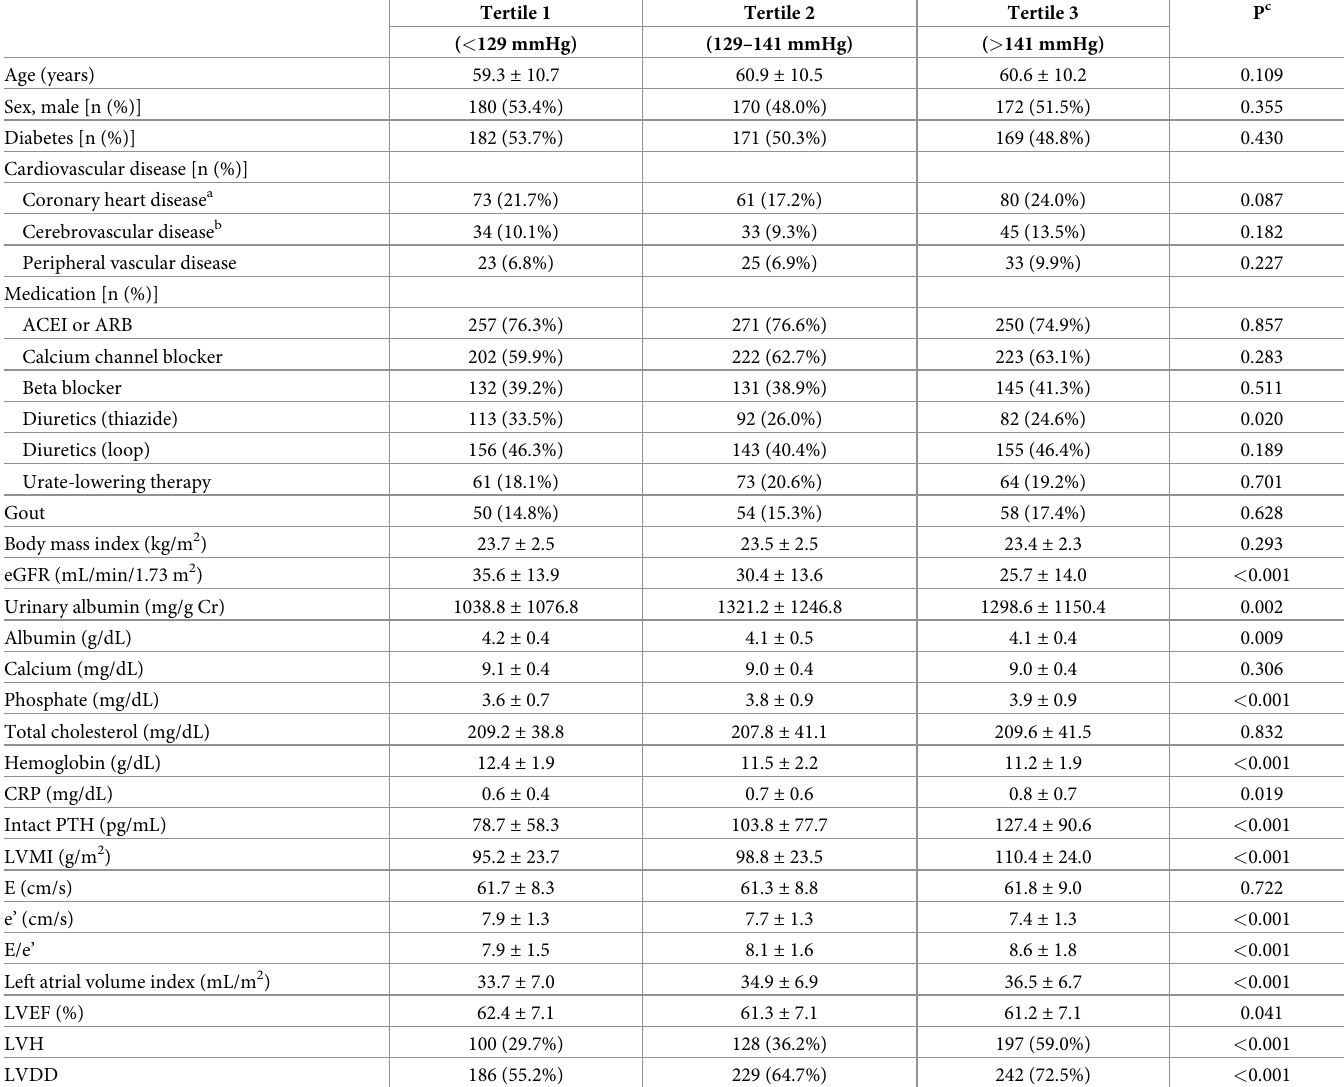
Table 3. Baseline characteristics of the study population according to tertiles of systolic blood pressure values (n = 1025). Tertile